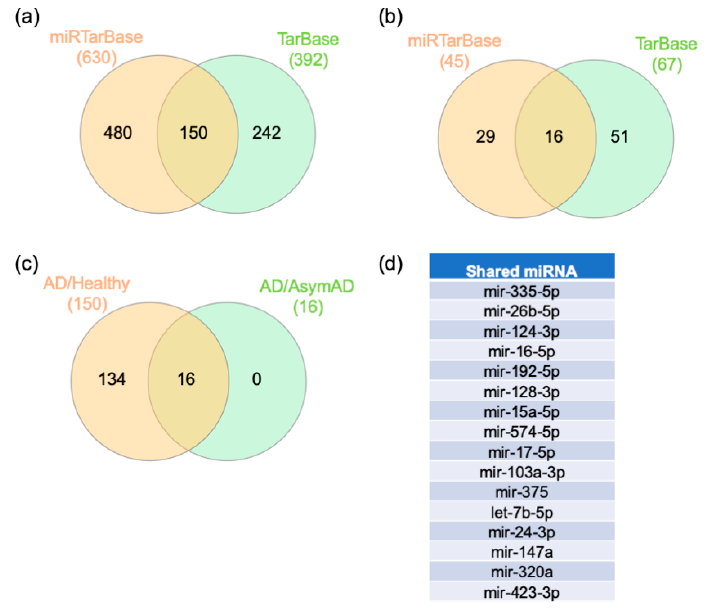
Figure 6. Analysis of miRNAs. Analysis of miRNAs from AD/control and AD/AsymAD switch genes. The gene–transcription factor interaction network was performed with miRTarBase and TarBase. Venn diagram analysis was performed to identify the miRNAs for AD/healthy ( a ) and AD/AsymAD analysis ( b ) shared between the databases. A Venn diagram determined the miRNA shared between both analyses ( c , d ). AD: Alzheimer’s disease. AsymAD: asymptomatic